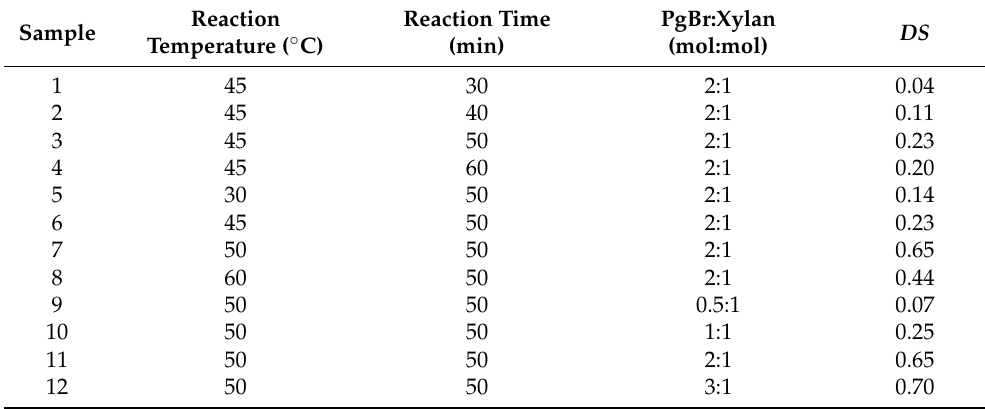
Table 1. DS of Pg-Xylan obtained under different reaction